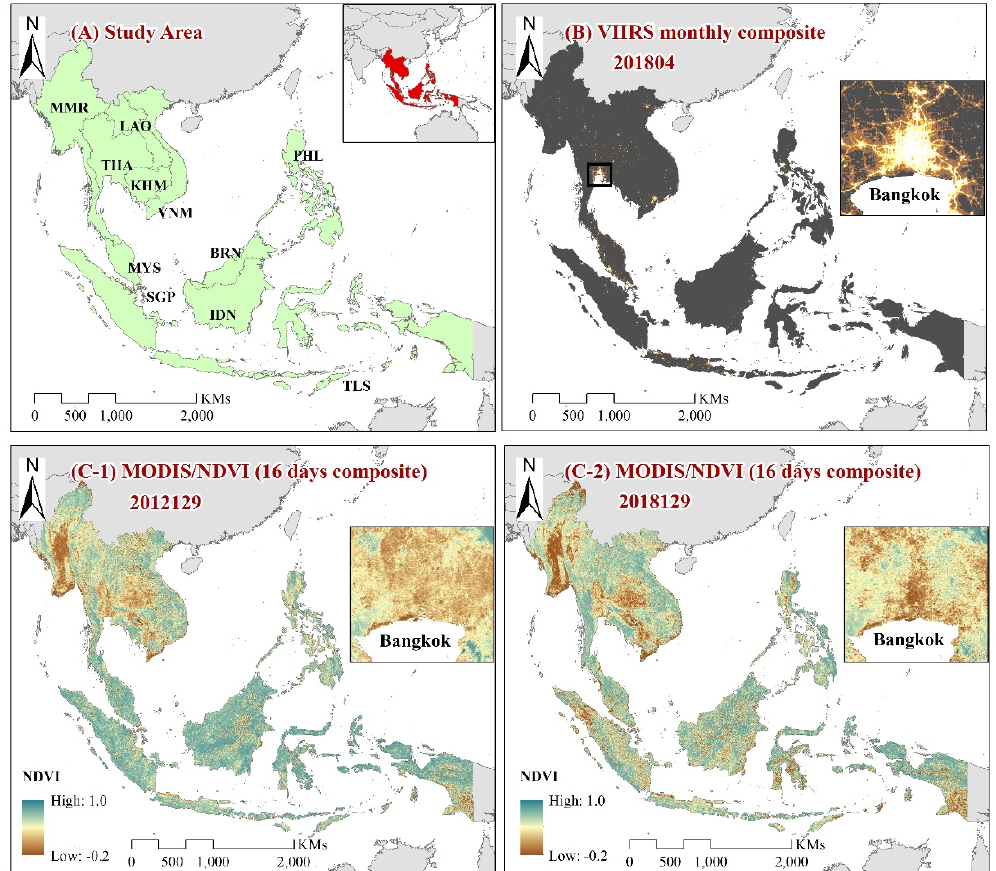
Figure 1. (A) Study area of Southeast Asia, (B) original Visible Infrared Imaging Radiometer Suite Figure 1. ( A ) Study area of Southeast Asia, ( B ) original Visible Infrared Imaging Radiometer Suite - Day/Night Band ‐ Day/Night Band (VIIRS/DNB) monthly composite data for 2018.04, and (C) 16 days composite of (VIIRS/DNB) monthly composite data for 2018.04, and ( C ) 16 days composite of moderate resolution imaging spectro- moderate resolution imaging spectroradiometer (MODIS)/normalized difference vegetation index radiometer (MODIS)/normalized difference vegetation index (NDVI) data for 9 May 2012 (2012129) and 10 May 2018 (NDVI) data for 9 May 2012 (2012129) and 10 May 2018 (2018129). Table 1. The basic information for 11 countries in Southeast Asia (SEA), including name abbrevia ‐ tion (Abbr.), area, 2012 and 2018 population (pop), 2008 ‐ 2017 annual growth rate (an_gr) of urban population (U ‐ pop), 2008 ‐ 2017 annual growth rate of rural population (R ‐ pop), and 2008–2017 annual growth rate of gross domestic product (GDP). The data are collected from the DataBank of World Bank (https://data.worldbank.org.cn/).